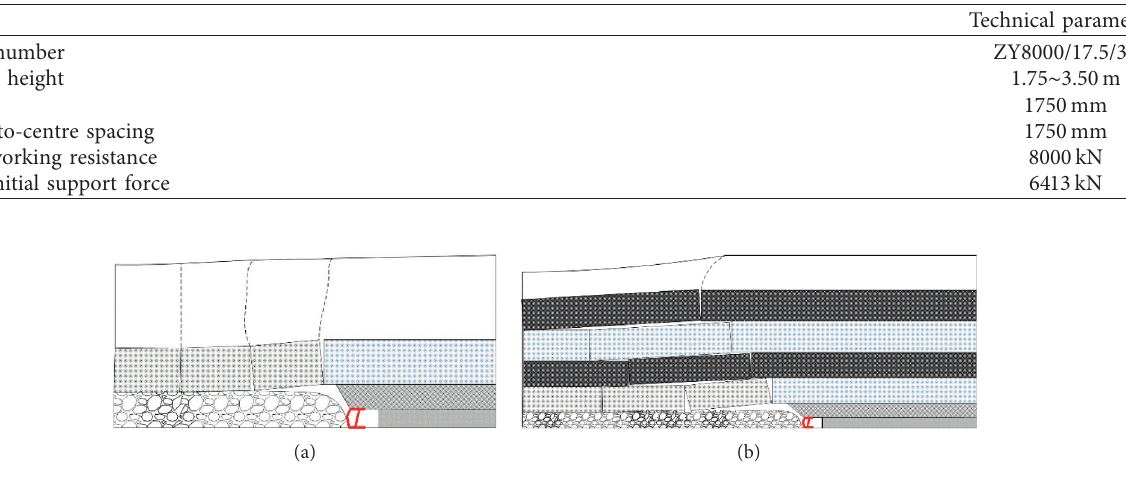
Figure 3: Schematic diagram of masonry beam structure. (a) Short masonry beam. (b) General masonry